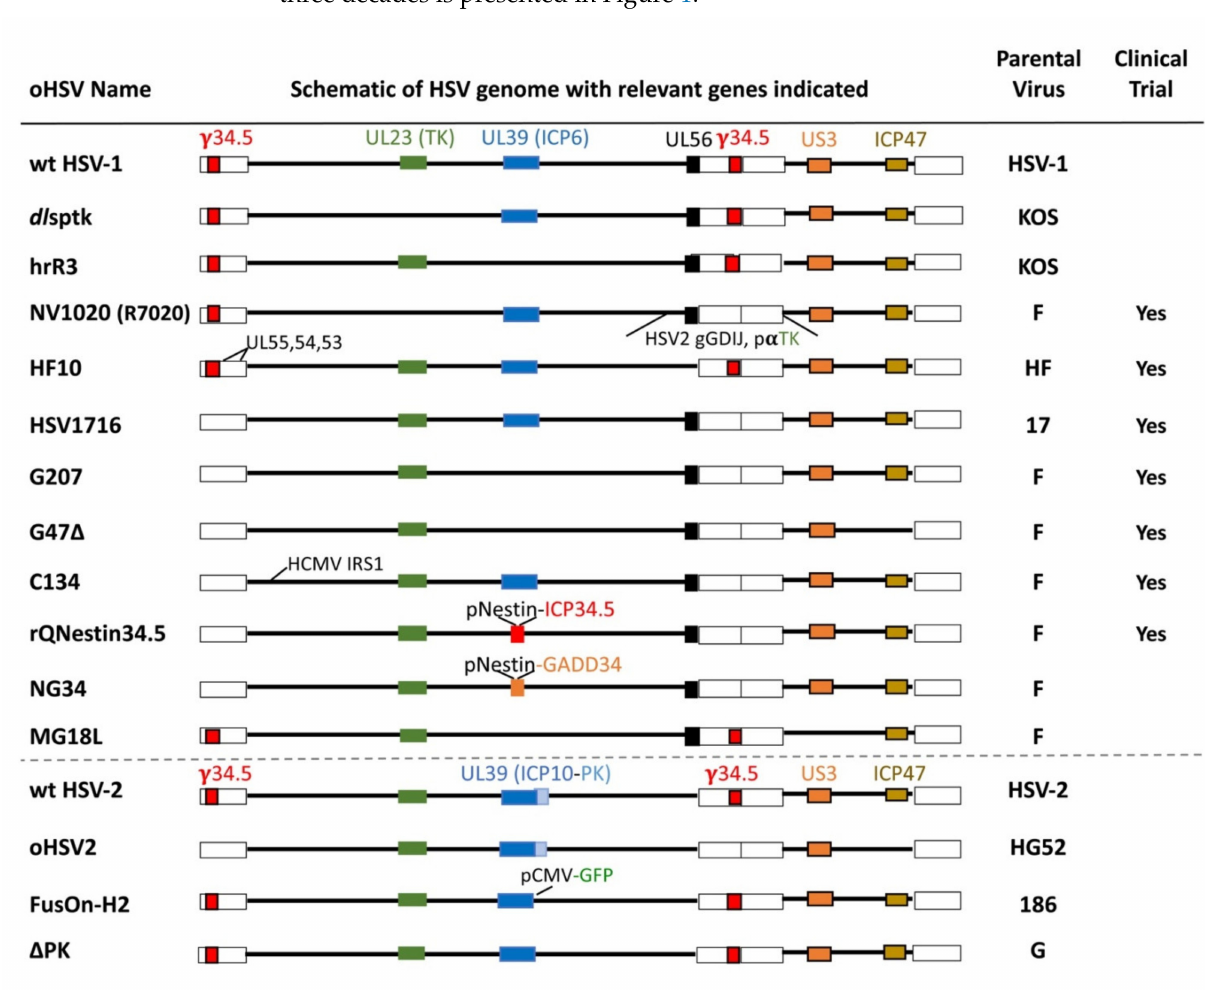
Figure 4. The major un-armed oHSVs with important gene modifications indicated. Abbreviations: wt, wild type; PK, protein kinase; gGDIJ, glycoproteins G, D, I, J; p α TK, α promoter driving TK; pNestin, nestin promoter-enhancer; pCMV, CMV promoter; and GFP, green fluorescent